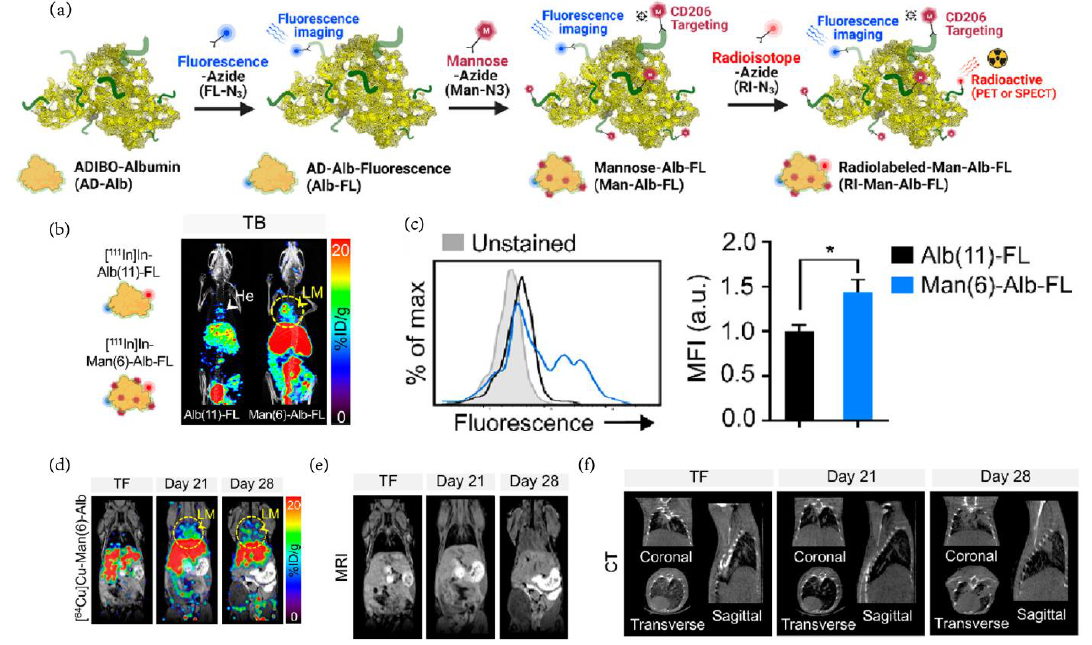
Figure 6. ( a ) Schematic representation of MSAs using click reaction in AD-Alb with other functional molecules. ( b ) SPECT/CT images of 4T1-bearing mice (TB) injected with [ 111 In]In-Alb(11)-FL or [ 111 In]In-Man(6)-Alb-FL on day 28. ( c ) Fold change in MFI of colabeled FNR-648 on CD 206+ macrophages from 4T1-bearing mice following injection with Alb(11)-FL or Man(6)-Alb-FL Statistical analysis between groups: (*) p < 0.05.( d ) Representative PET/MRI images of [ 64 Cu]Cu-Man(6)-Alb- FL. Representative MRI ( e ) and CT ( f ) images show strong signals from lung metastases on day 28, while no significant change was detected at an earlier stage (day 21) [49]. Copyright 2022, American Chemical Society (Reprinted from ref. [49] under the terms of the Creative Commons CC BY